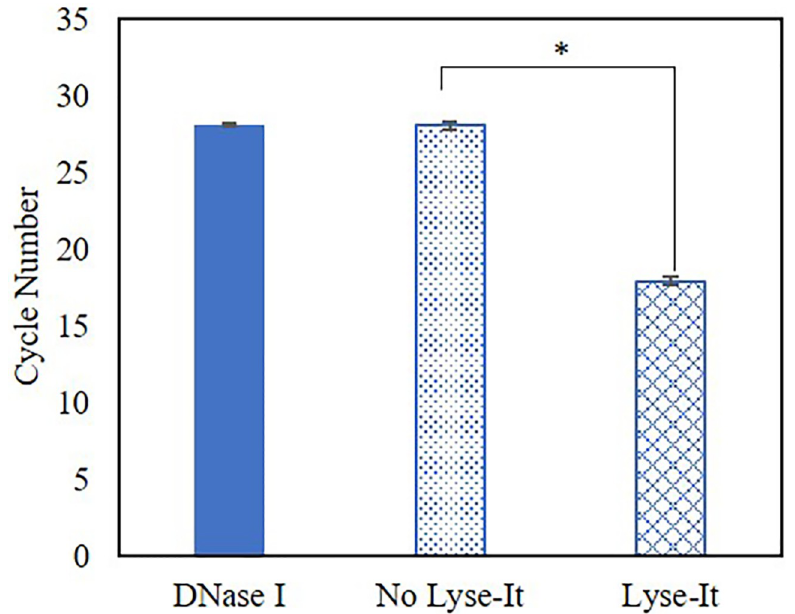
Fig 12. qPCR cycle number for amplified V . cholerae DNA before and after a 10-minute exposure to DNase I without microwave irradiation (DNase I), after 50% power 60 seconds standard microwave irradiation (No Lyse- It) and after 50% power, 60 seconds with Lyse-It (Lyse-It). A decrease in cycle number is seen with Lyse-It because the V . cholerae DNA is intact as compared to being chewed-up by intact DNase I. � = p =